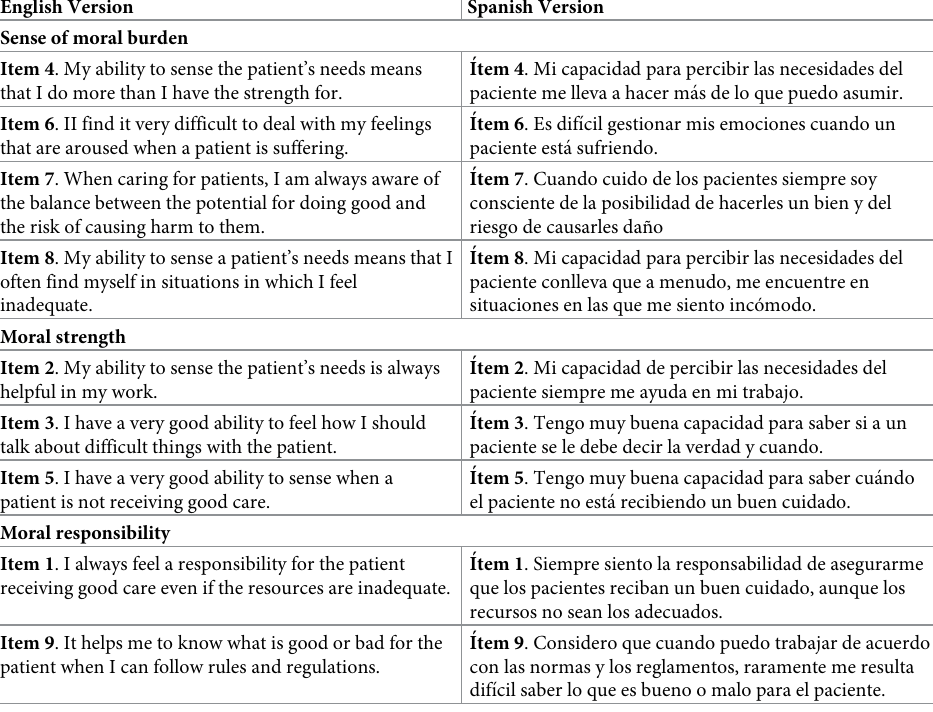
Table 1. Lexical and semantic equivalence of the MSQ-SPV. English